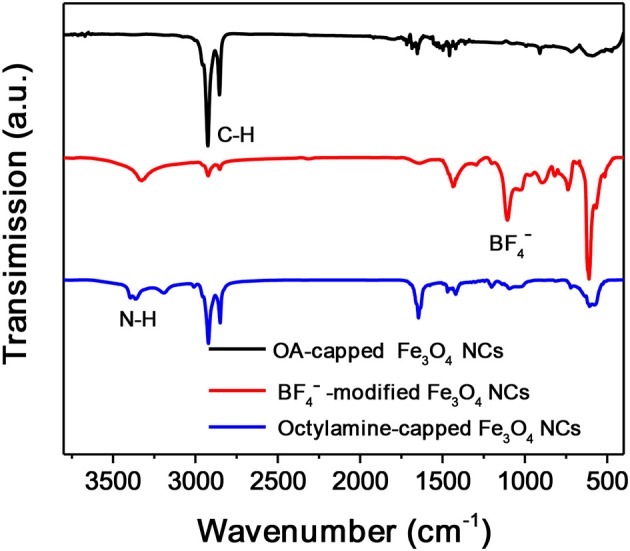
FTIR spectra of Fe3O4 NCs capped with OA, BF4-, and octylamine, respectively.